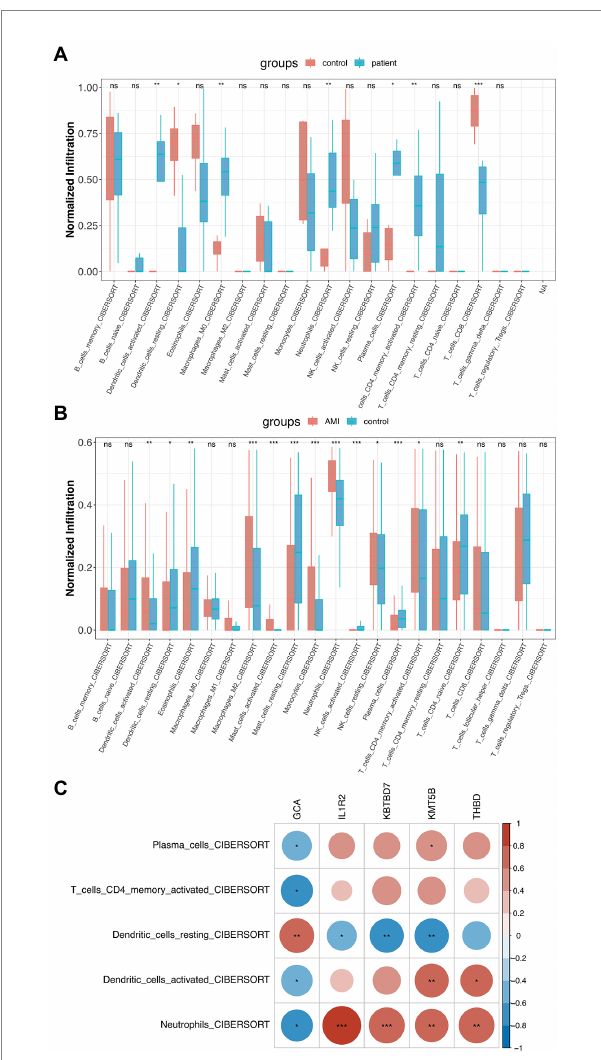
FIGURE 4 Immunological implications of the feature genes. (A) Comparison of infiltrating immune cells in patients who were COVID-19-positive and-negative. (B) Comparison of infiltrating immune cells in patients with AMI and healthy controls. (C) Correlation analysis of feature genes and the 5 shared differentially regulated immune